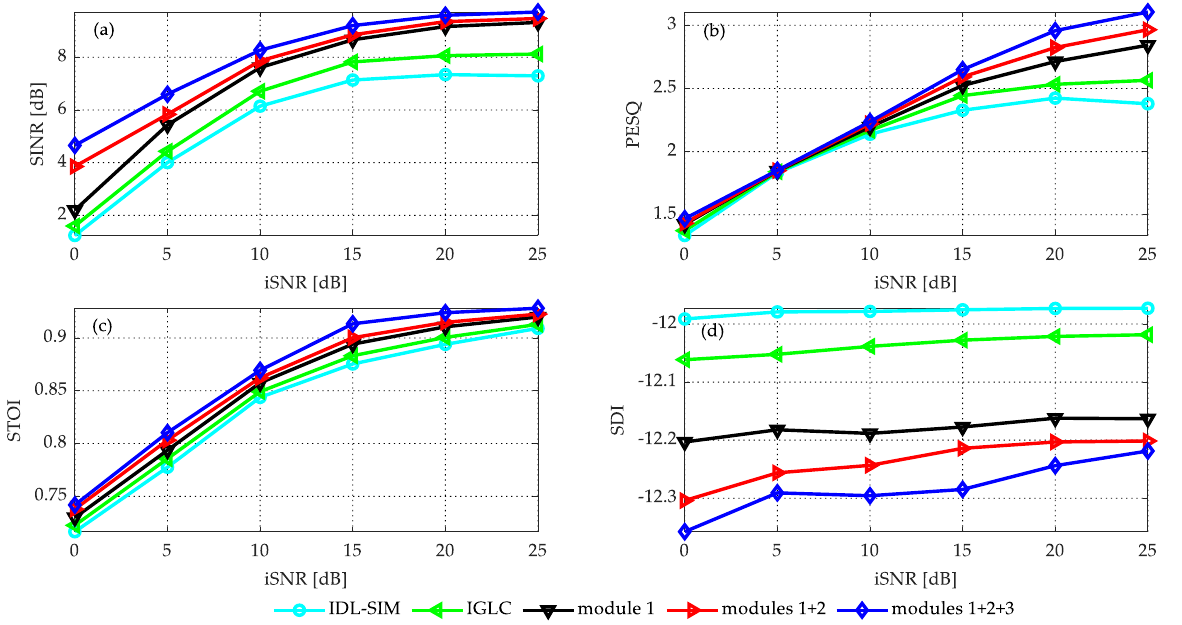
Figure 6. The evaluation results of the optimization modules under different iSNRs: ( a ) SINR; ( b ) PESQ; ( c ) STOI; ( d ) SDI.